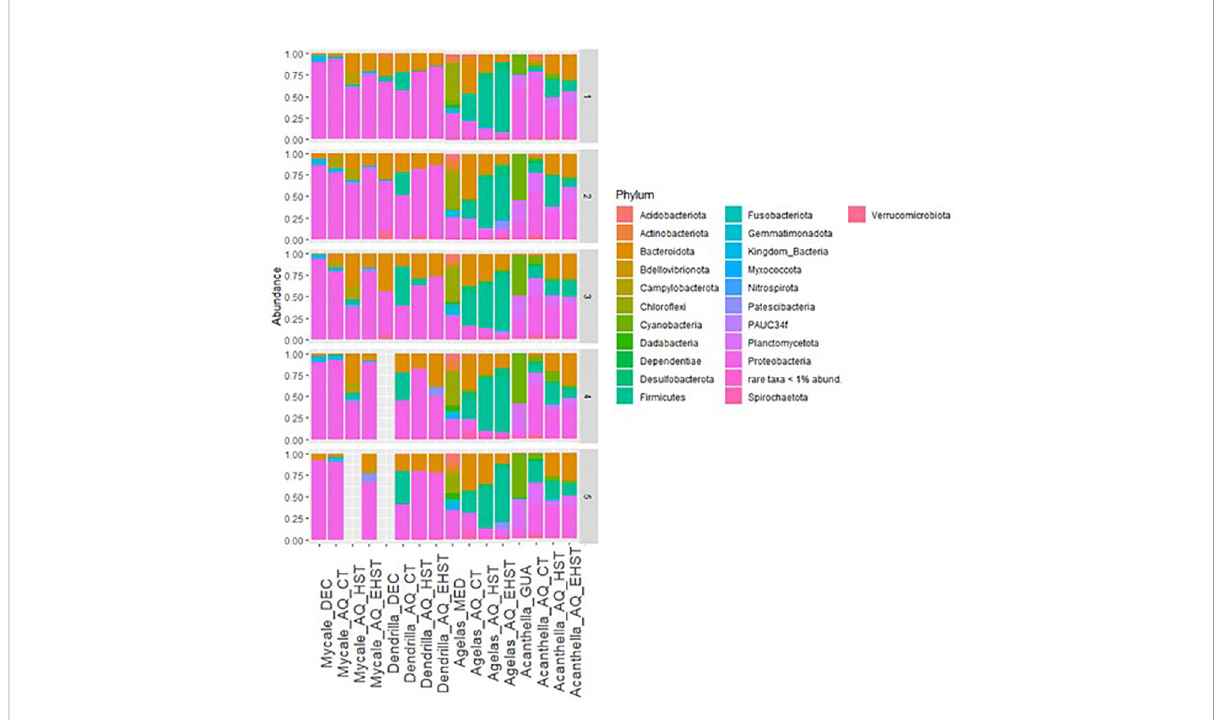
FIGURE 6 Taxonomic af fi liation of ASVs at Phylum level in sponge species in their natural habitat and in the aquaria exposed at different temperatures (CT, control temperature, HST, heat stress temperature, EHST, extreme heat stress temperature). DEC, Deception Island; MED, Roses and Cadaque ́ s origin; GUA, Guam; SW, seawater. Numbers on the right axis indicate sample replicates. AQ, aquarium